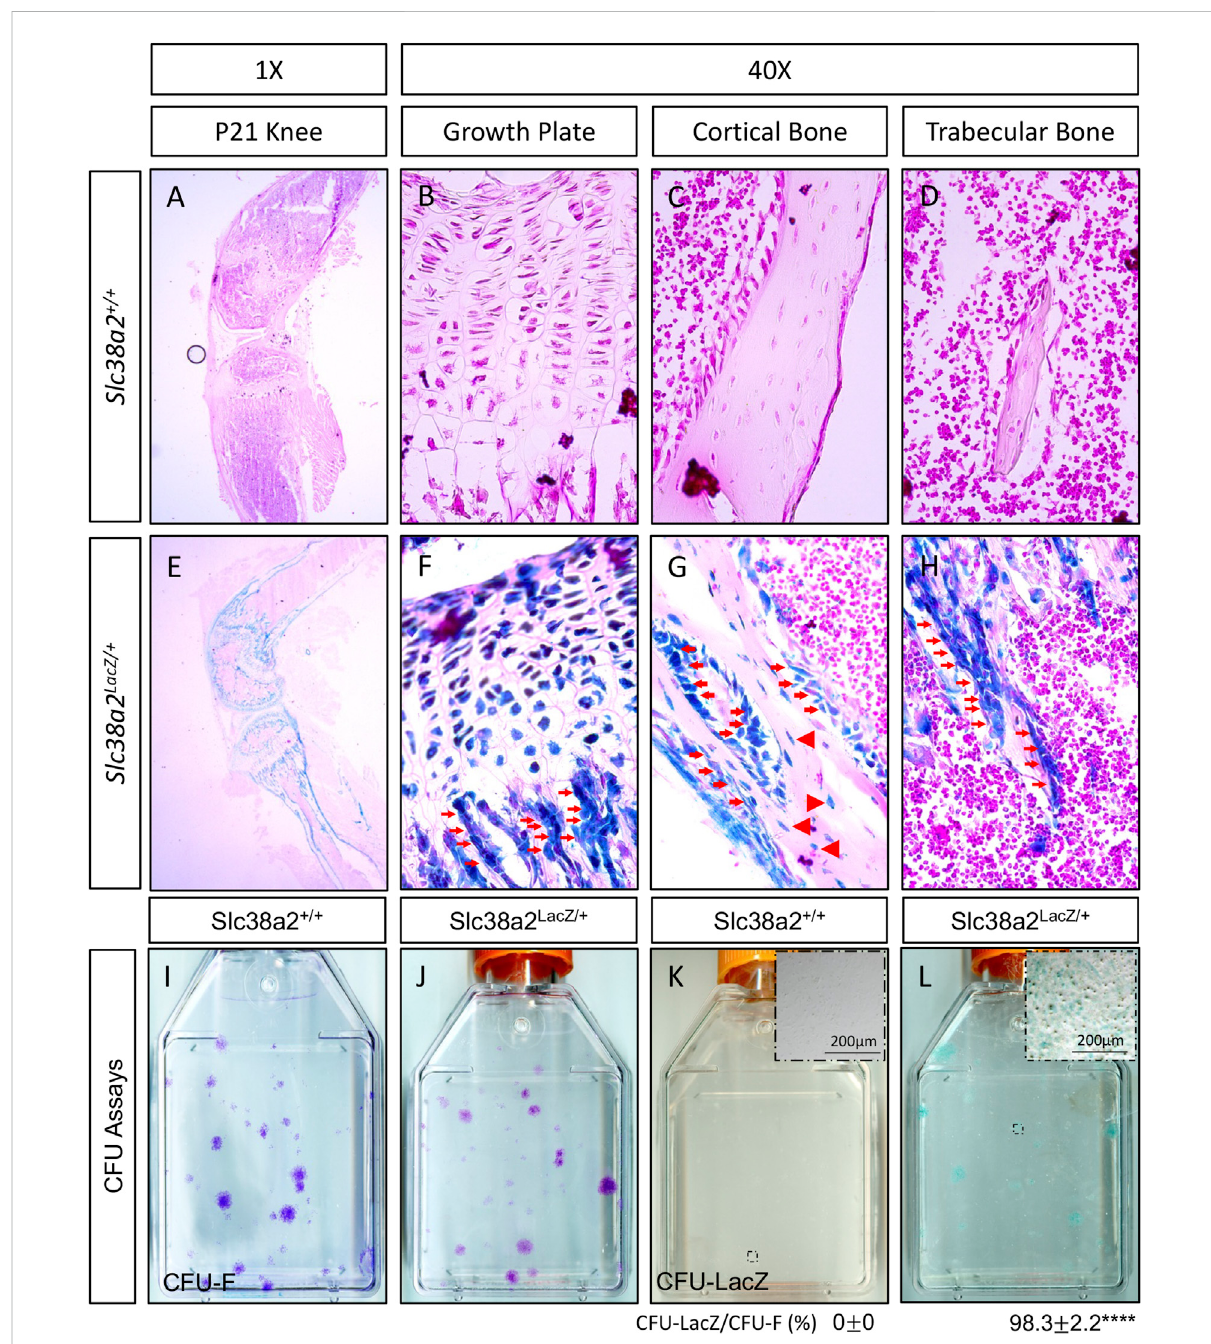
SLC38A2 is expressed in osteoblast lineage cells after parturition. (A – H) Postnatal day 21 (p21) Slc38a2 +/+ (wild type) (A – D) or Slc38a2 LacZ/+ (E – H) knees stained with X-gal [dark blue in (E – H) ]. LacZ staining is apparent in articular and growth plate chondrocytes, osteoblasts [red arrows in ( G – H )] and osteocytes [arrowheads in (G) ]. Note the absence of staining in the wild type mice that don ’ t express LacZ. Representative images of colony forming unit (CFU) assays stained with Crystal Violet (I – J) or X-gal (K,L) performed on 2-month-old wild type (I,K) or Slc38a2 LacZ/+ (J,L) littermates. Note the presence of LacZ expressing colonies in (L) . Inset image in (K – L) shows high magni fi cation image of individual colony. Quanti fi cation of proportion of total colonies that are also LacZ positive shown below. **** p < 0.00005, N = 4